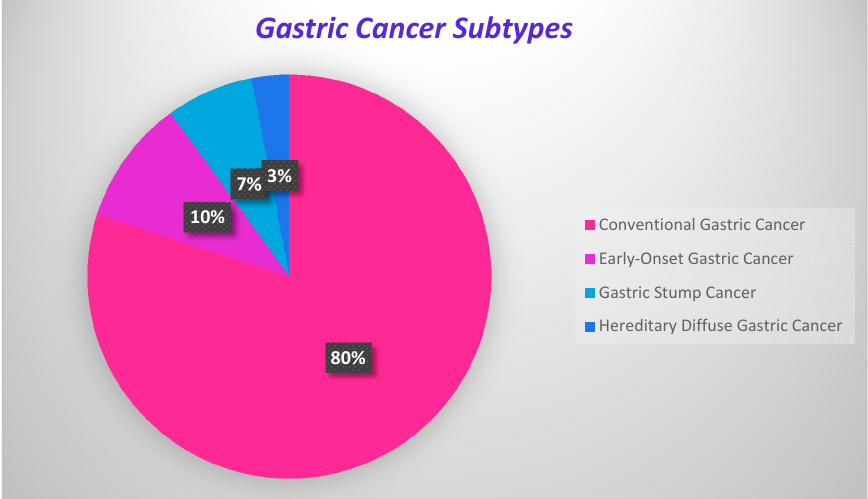
Diagram 2. Onsets of gastric cancer development. Figure 2. Onsets of gastric cancer